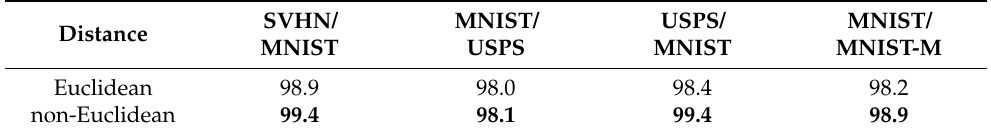
Table 4. The performance of the proposed method without applying any noise. Distance